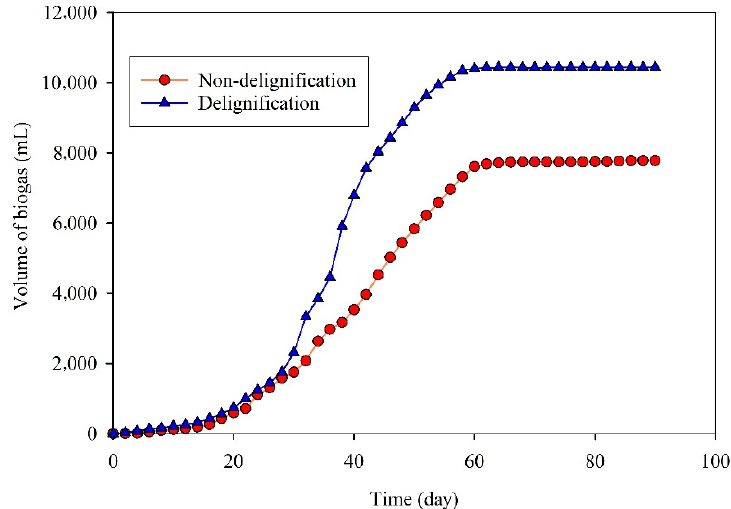
Figure 12. Effect of different pretreatments on the biogas production of 20% total solids (TS) C/N 25 (g/g).